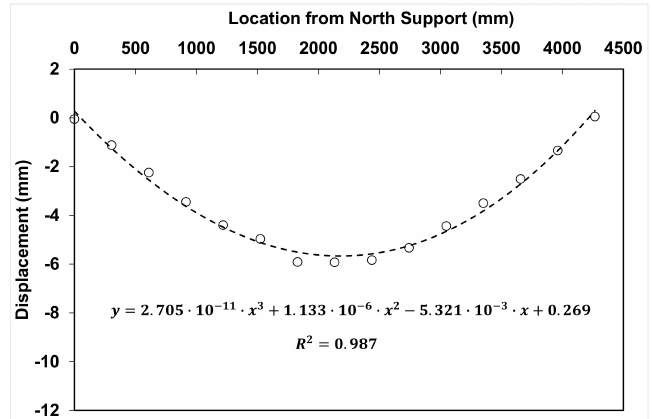
Figure 17. Deflection profile for control beam based on LVDT recorded measurements (circular marks) and deflection equation based on a third order polynomial trend line fitted to experimental data for a load P = 194